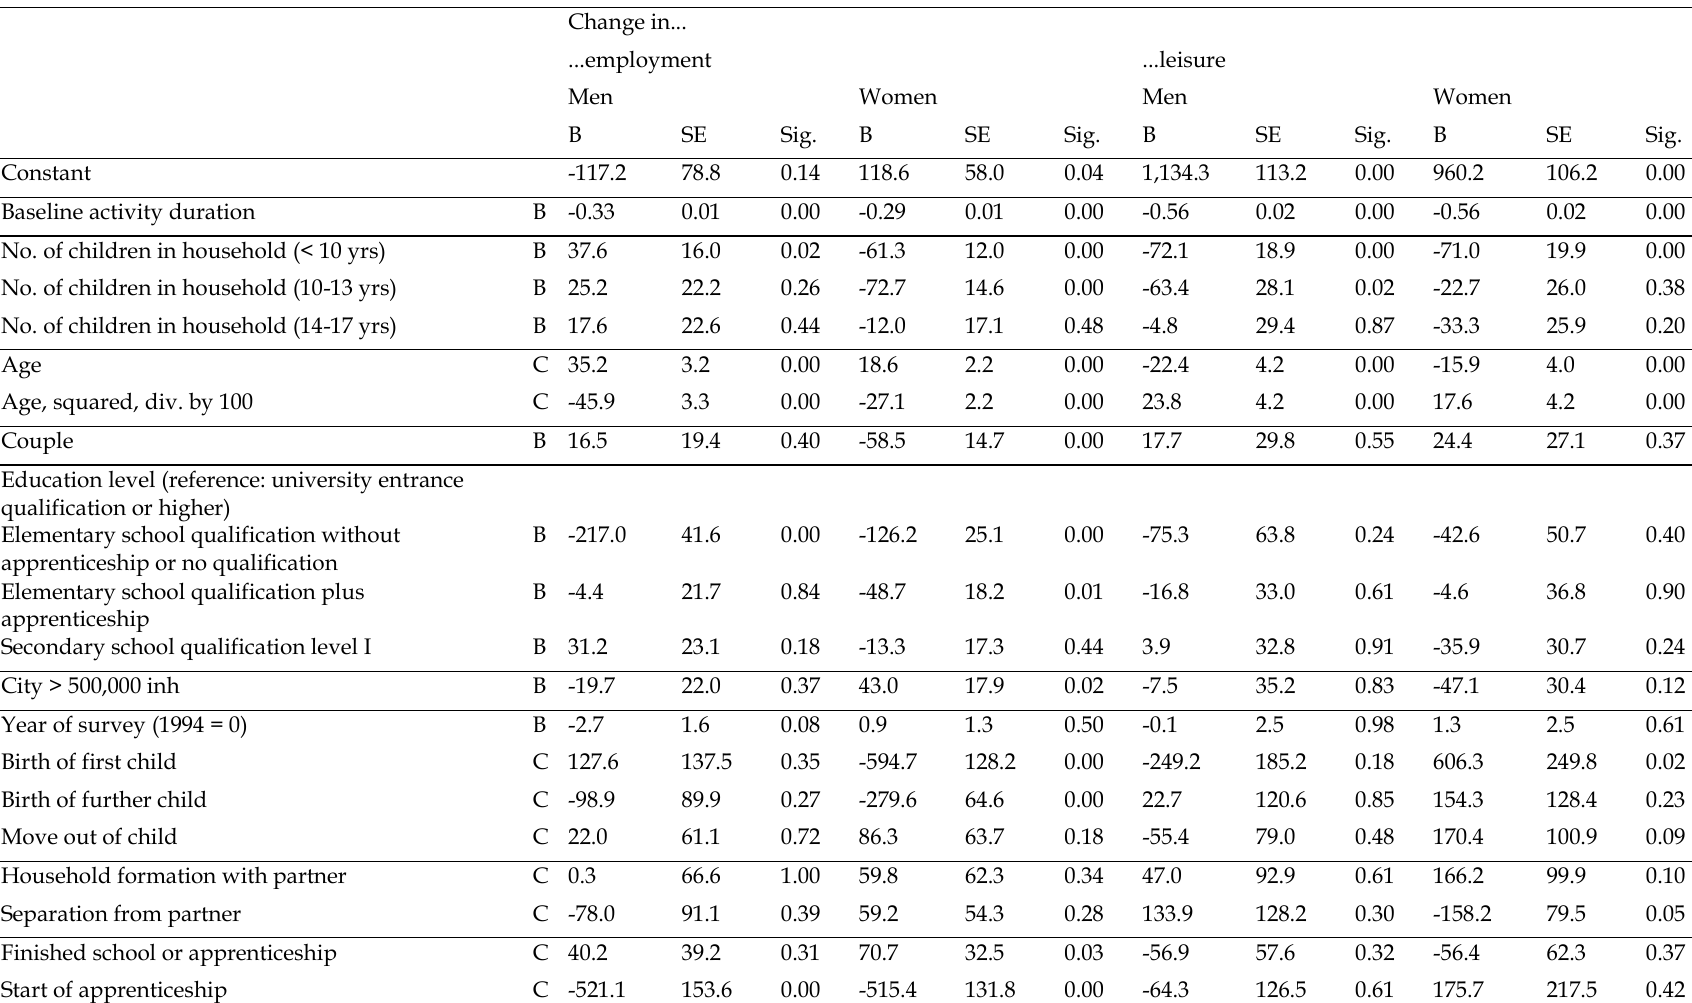
Table 4. Cluster-robust regression models of changes in time used for employment and leisure activities Change